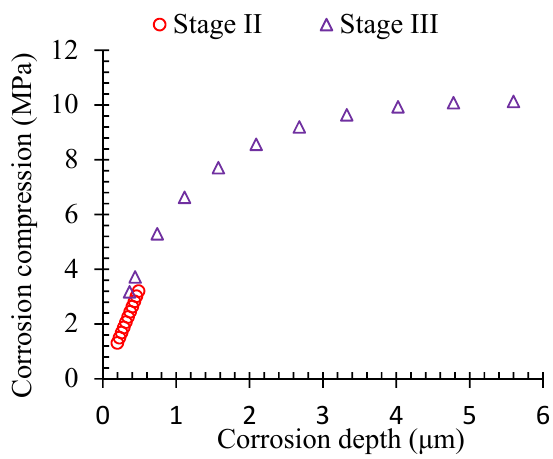
Figure 10. Displacement of the concrete in the steel-concrete interface.